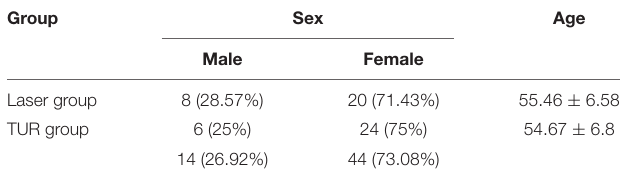
TABLE 1 | Baseline characteristics.